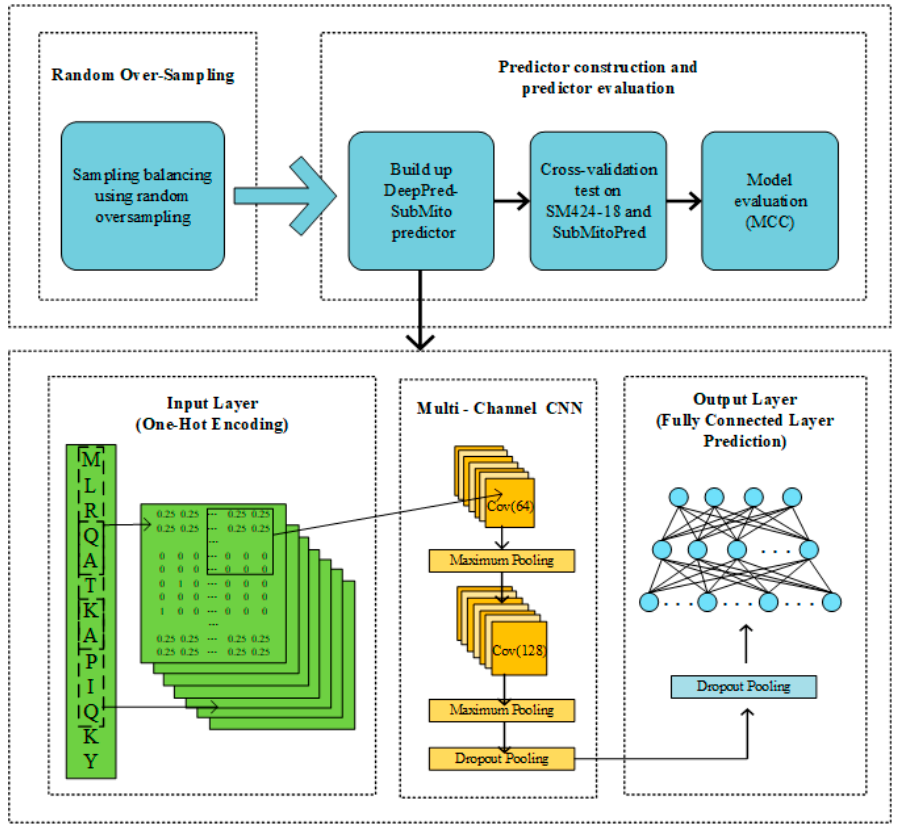
Figure 6. A flowchart of protein submitochondrial localizations prediction based on the DeepPred- SubMito